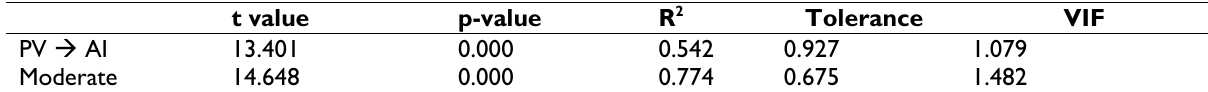
Table 6. Moderated Regression Analysis Result